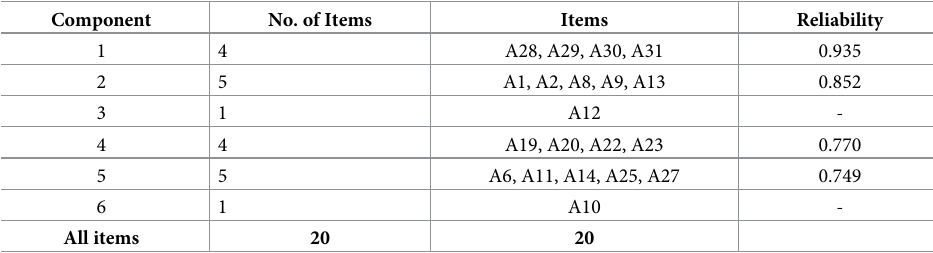
Table 7. The item and component of work